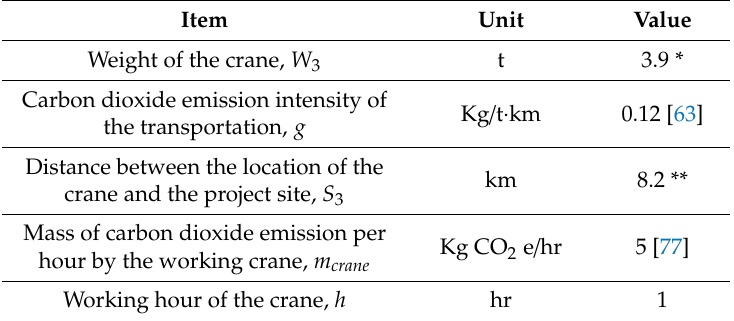
Table 10. Parameters of estimating the carbon dioxide emission in the crane transportation. Item Unit Value Weight of the crane, W 3 t 3.9 * Carbon dioxide emission intensity of Kg / t · km the transportation, g Distance between the location of the crane and the project site, S